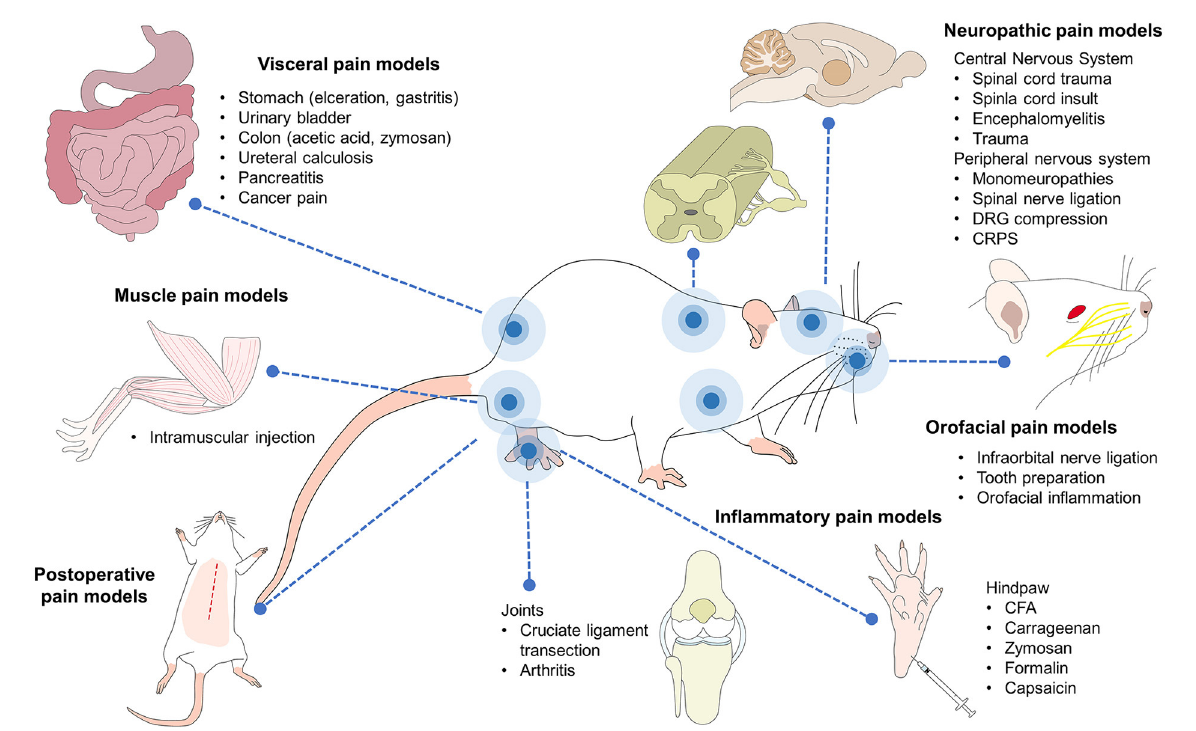
FIGURE3 Pain models in rodents. Current research with rodent models includes several aspects of medicine and biological sciences, including pain. Several inflammatory, neuropathic, visceral, muscle-skeletal, and postoperative pain are currently studied in rodents. Orofacial, cancer, head, and burn pain are also part of the biomedical research where mice and rat play a key role in the comprehension of the physiopathology as well as the development of analgesic